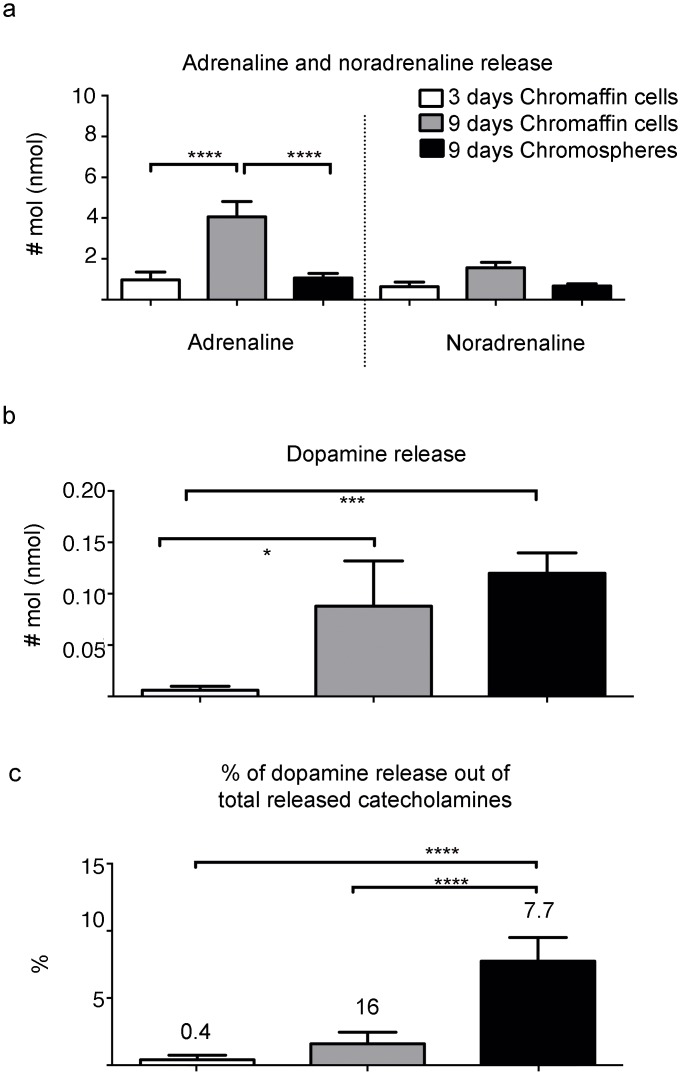
In vitro analysis of noradrenaline, adrenaline and dopamine release in chromospheres and CC.(a-b) Adrenaline, noradrenaline and dopamine release under basal conditions was determined by HPLC-ED in 3- and 9- days cultured-CC and 9 days cultured-chromospheres. 3 days CC and 9 days chromospheres were obtained from 8 independently processed adrenal glands, whereas 9 days CC were obtained from 3 independently processed adrenal glands. Data collection and analysis from cells obtained from different glands was also done separately. The extracellular medium was recollected for quantification of released catecholamines. Catecholamine quantities are expressed in nmol. (a) Significant differences were observed for adrenaline (3-days CC: 0.9726 ± 0.3828 nmol; 9-days CC: 4.057 ± 0.7481 nmol; 9-days chromospheres: 1.065 ± 0.2261 nmol; multivariate ANOVA, P > 0.05, F = 17.36, DF = 2, p < 0.0001; followed by Tukey´s multiple comparisons post hoc test, p < 0.0001****) and (b) dopamine (3 days CC: 0.0058 ± 0.0038 nmol; 9 days CC: 0.087 ± 0.043 nmol; 9 days chromospheres: 0.12 ± 0.019 nmol; ANOVA, P > 0.05, F = 12.53, r2 = 0.6103, p = 0.0005; followed by Tukey´s multiple comparisons post hoc test, p = 0.0145* and p = 0.0004***). (c) Graphic representation of the percentage of dopamine released relative to the total catecholamines released (adrenaline + noradrenaline + dopamine). Significant differences were observed between 9-days chromospheres compared to 9 and 3 days CC (ANOVA, P > 0.05, F = 27.42, r2 = 0.7231, p < 0.0001; followed by Tukey´s multiple comparisons post hoc test, p < 0.0001****).